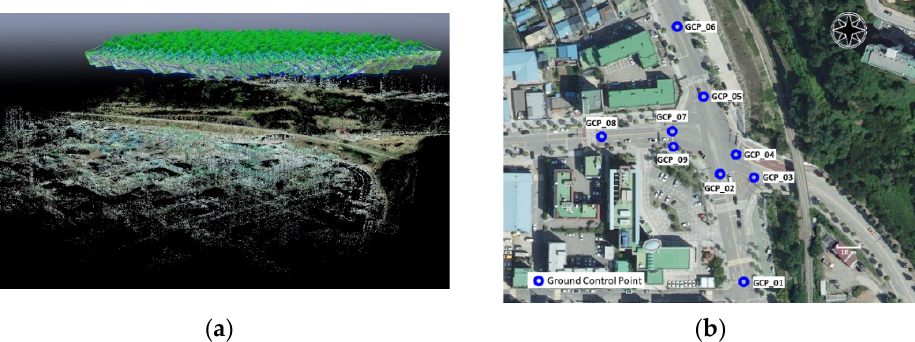
Figure 8. Calibration using initial processing and Ground Control Point (GCP): ( a ) Initial processing; ( b ) Ground Control Point (GCP).